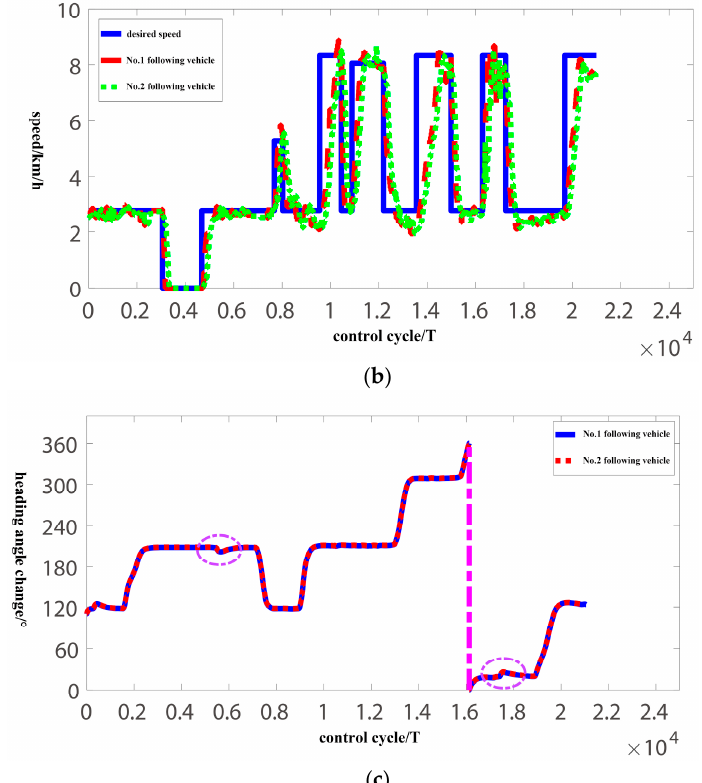
Figure 9. Lateral and longitudinal movement trajectory of bus platoon. ( a ) Path following curve; ( b ) Speed tracking curve; ( c ) Vehicle heading change.